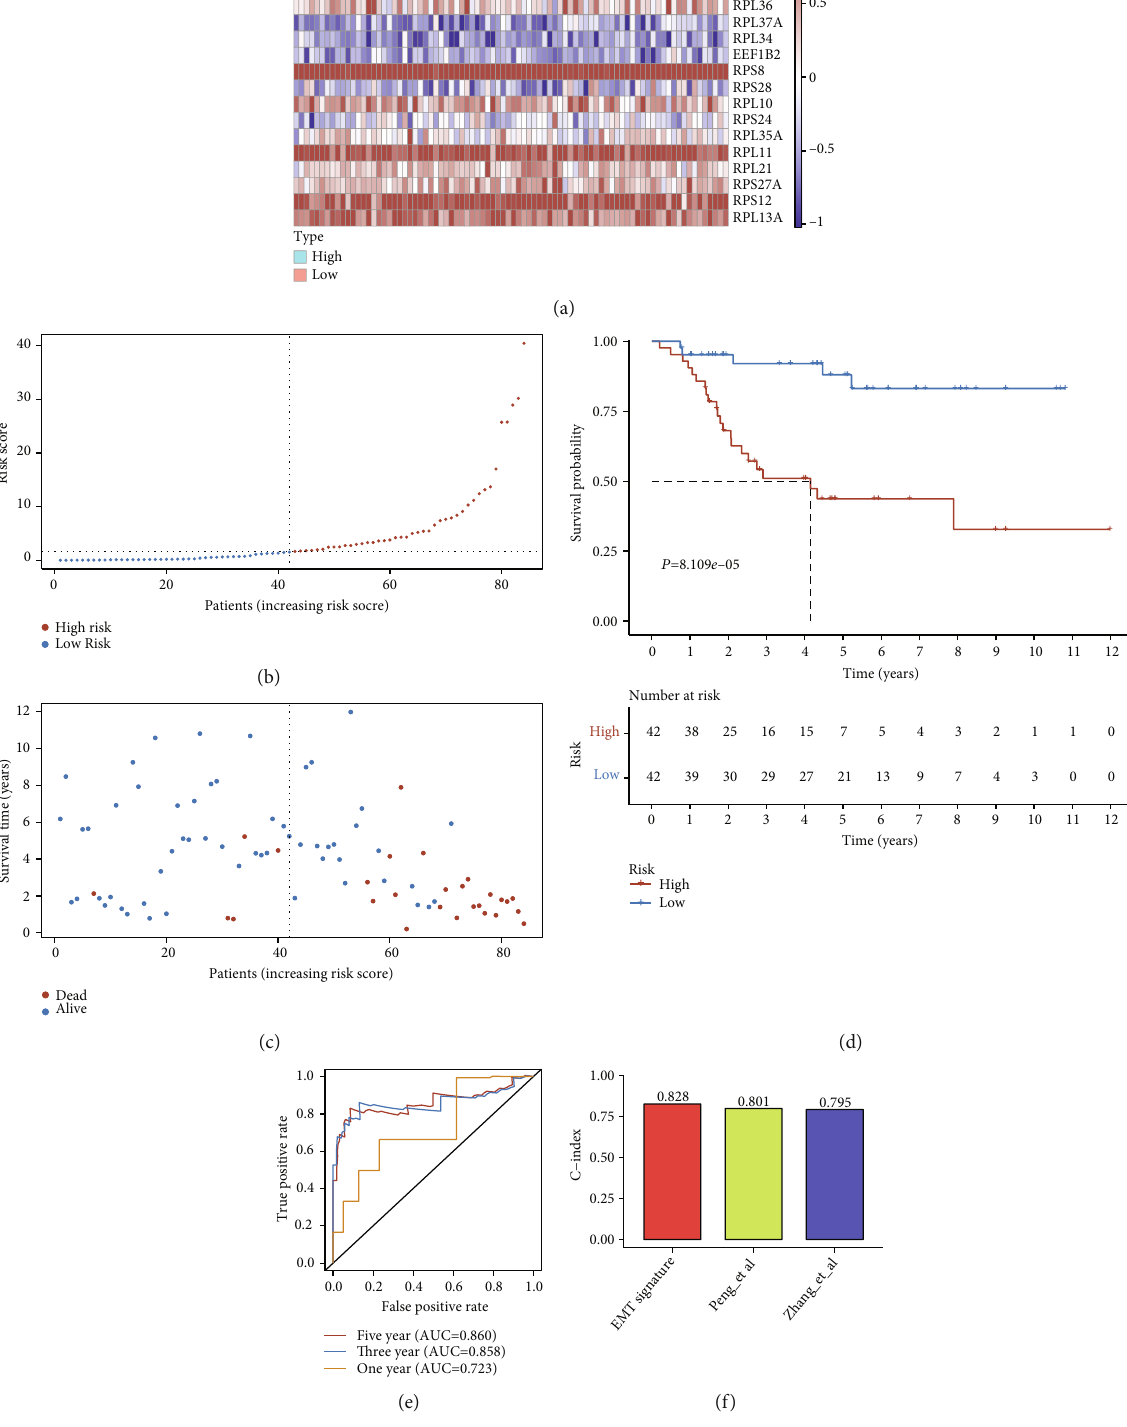
Figure 6: Development of EMT score for osteosarcoma prognosis in the TARGET cohort. (a) Heat map depicts the expression of each gene from EMT score in each osteosarcoma specimen. Red is indicative of upregulation; and blue is indicative of downregulation. (b) The distribution of risk score among osteosarcoma individuals. Vertical dotted line is indicative of the median value of EMT score. (c) The distribution of survival status of high- and low-risk subgroups. (d) Kaplan-Meier survival analyses for two subgroups. (e) ROC curves at one-, three-, and fi ve-year survival in accordance with EMT score. (f) C-index of our EMT model and previously published two EMT models from Zhang et al. and Peng et